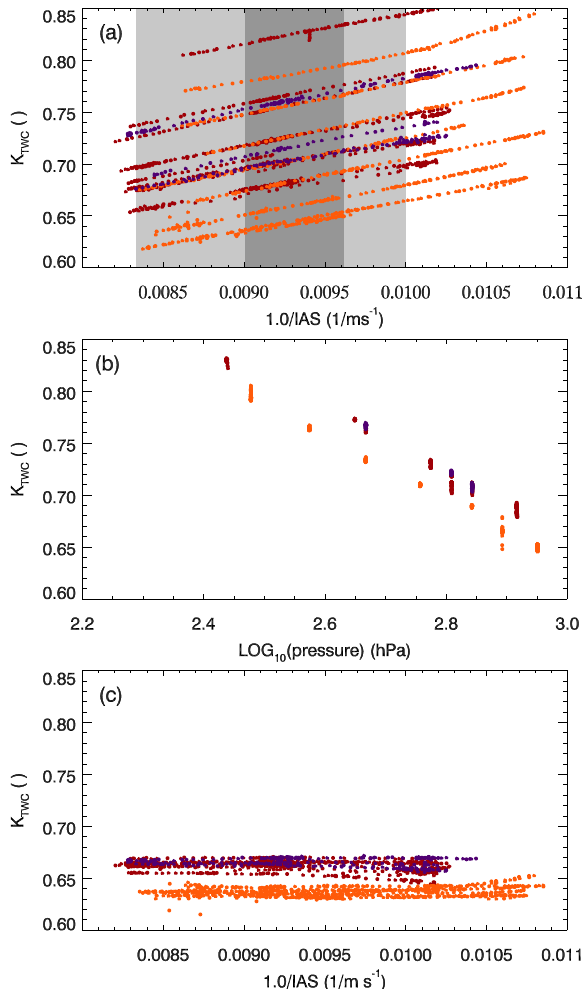
Figure A1. The change in cloud-free collector to reference sen- sor power during a number of straight and level runs. Panel (a) shows the effect of airspeed (each line of symbols are for one run at constant pressure, temperature and altitude, with only the airspeed varying). Panel (b) shows the response to pressure after an airspeed correction has been applied; panel (c) shows the response after ad- ditional pressure correction. The three different colours represent different